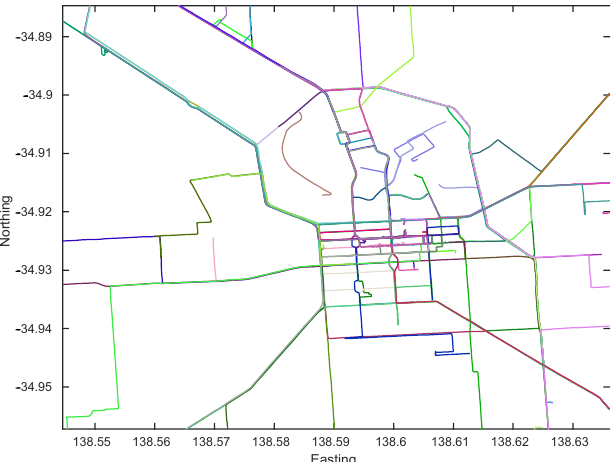
Figure 2. GPS Tracks of the image sequences collected around Adelaide CBD from Mapillary.